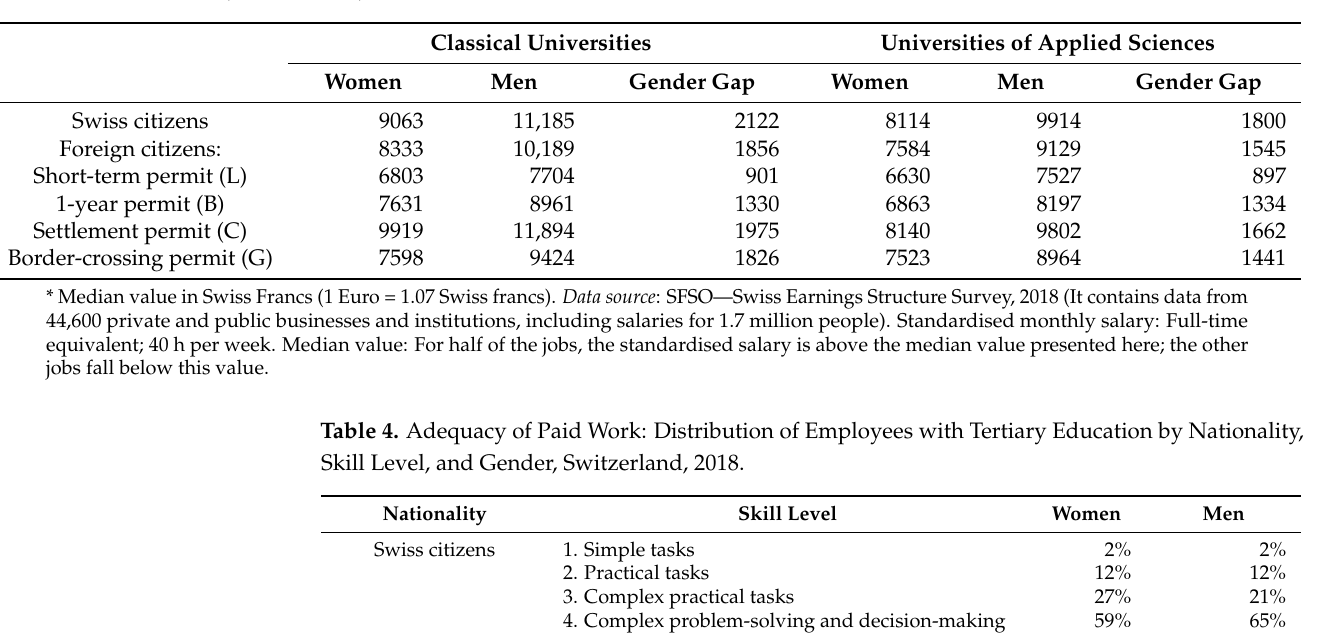
tasks. 2 = Practical tasks (e.g., sales, care, driving, security, use of machinery, data). 3 = Complex practical tasks that require knowledge in a specialised field. 4 = Tasks that require an ability to solve complex problems and make decisions based on specialised theoretical and factual